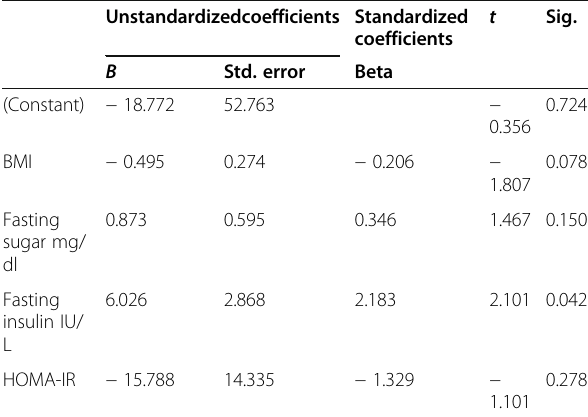
Table 9 Multivariate linear regression analysis for